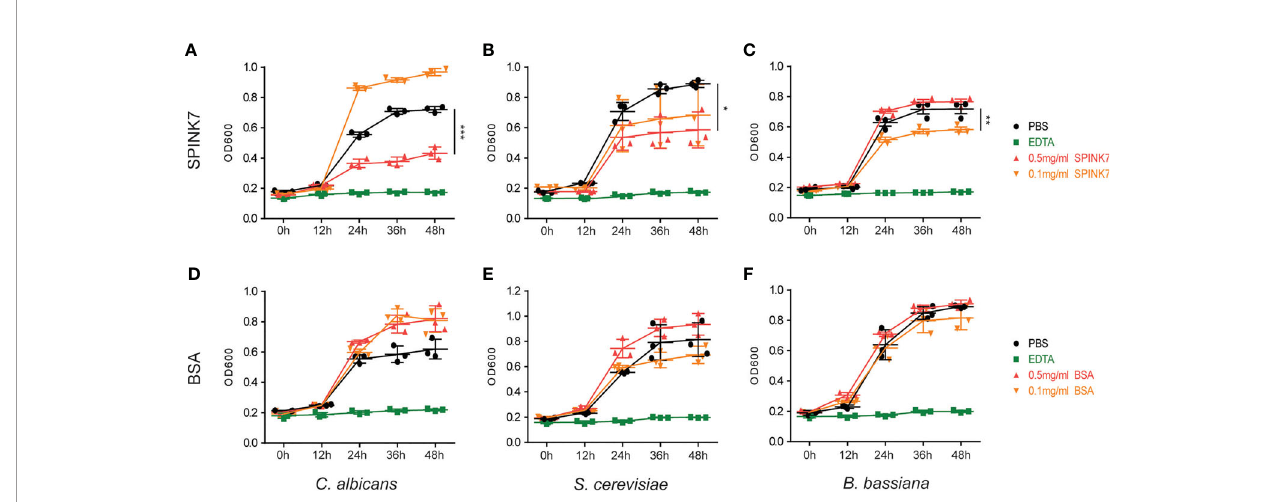
FIGURE 4 | Antifungal activity of SPINK7. The inhibitory effect of SPINK7 on the growth of (A) C. albicans , (B) S. cerevisiae , and (C) B. bassiana . The inhibitory effect of BSA on the growth of (D) C. albicans , (E) S. cerevisiae , and (F) B. bassiana . The bar graph shows the SPINK7-mediated inhibitory effect on fungal growth at 48 h. Bars indicate standard error (n = 3). Student ’ s t-test: *P < 0.05, **P < 0.01, ***P < 0.001.